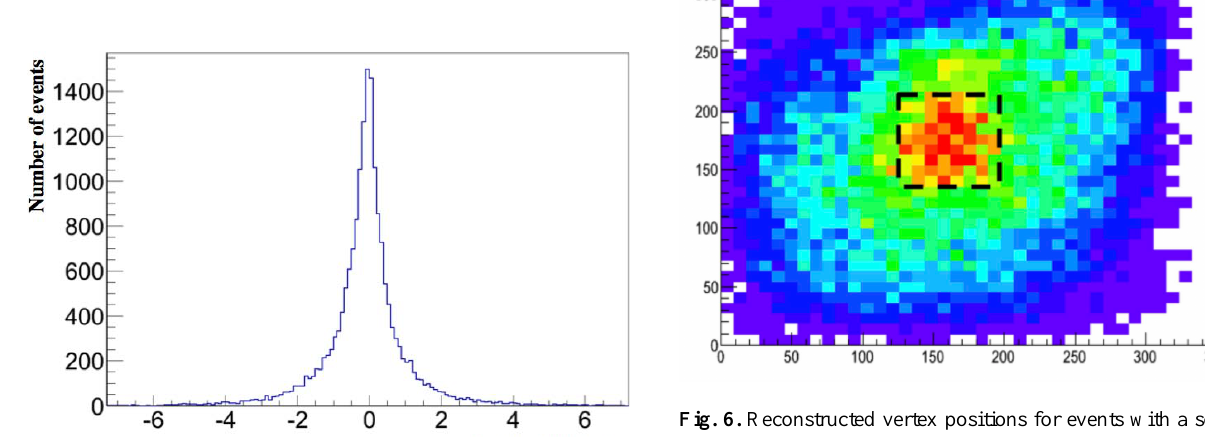
Fig. 3. Signal induced on the strips once the pedestal has been re- moved. The y-axis shows the converted digital value of the charge deposited in each strip; 1000ADC counts correspond to ca. 50pC. The peak due to a muon is clearly visible around strip 175.